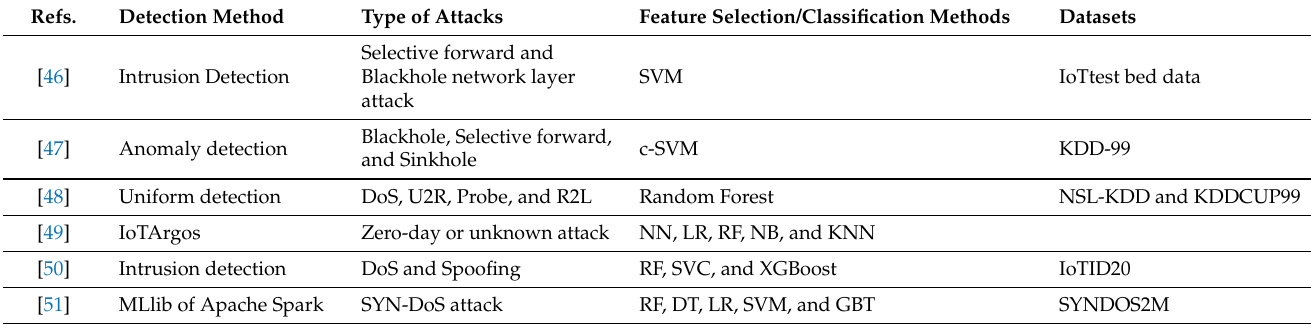
Table 3. Summary of supervised machine learning methods for cyber attack detection in IoT.